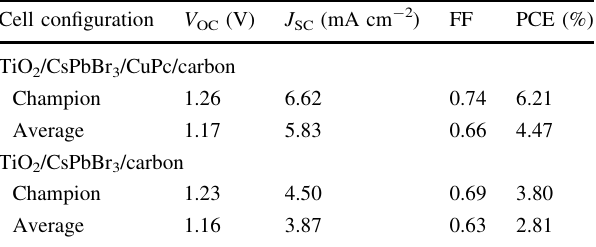
Table 1 Photovoltaic performance of the TiO 2 /CsPbBr 3 /CuPc/car- bon devices and TiO 2 /CsPbBr 3 /carbon devices measured under sim- ulated AM 1.5G (100 mW cm - 2 ) condition Cell